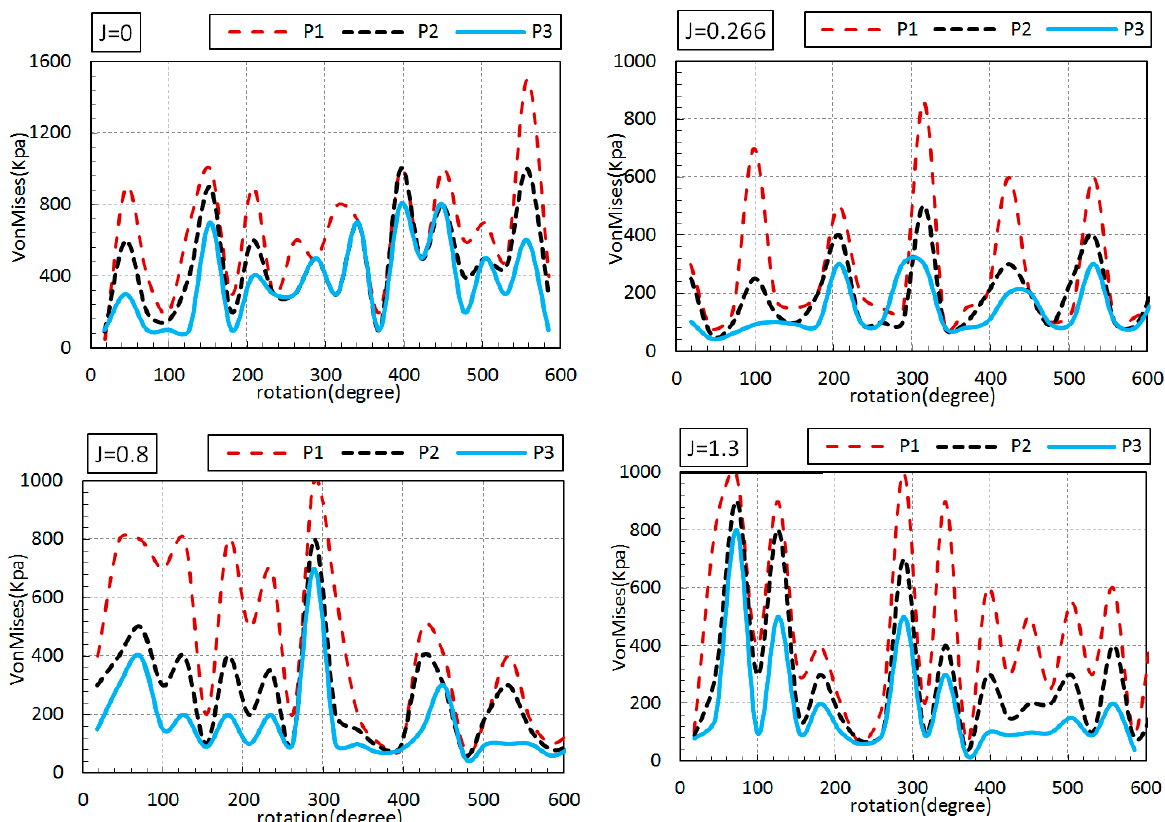
Figure 12. Maximum von Mises stress on a blade versus advance coefficient.